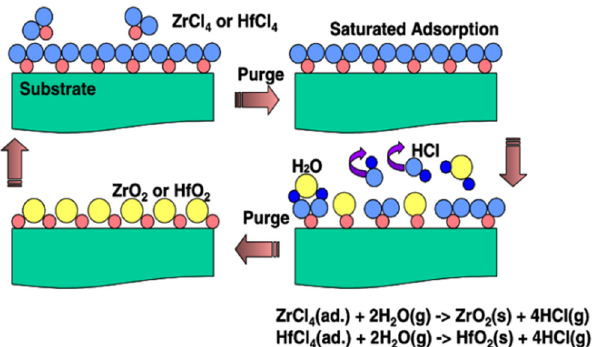
Figure 2. Schematic of the cyclic process of atomic layer deposition [7]. Reprinted with permission from [7]; 2015 Elsevier.